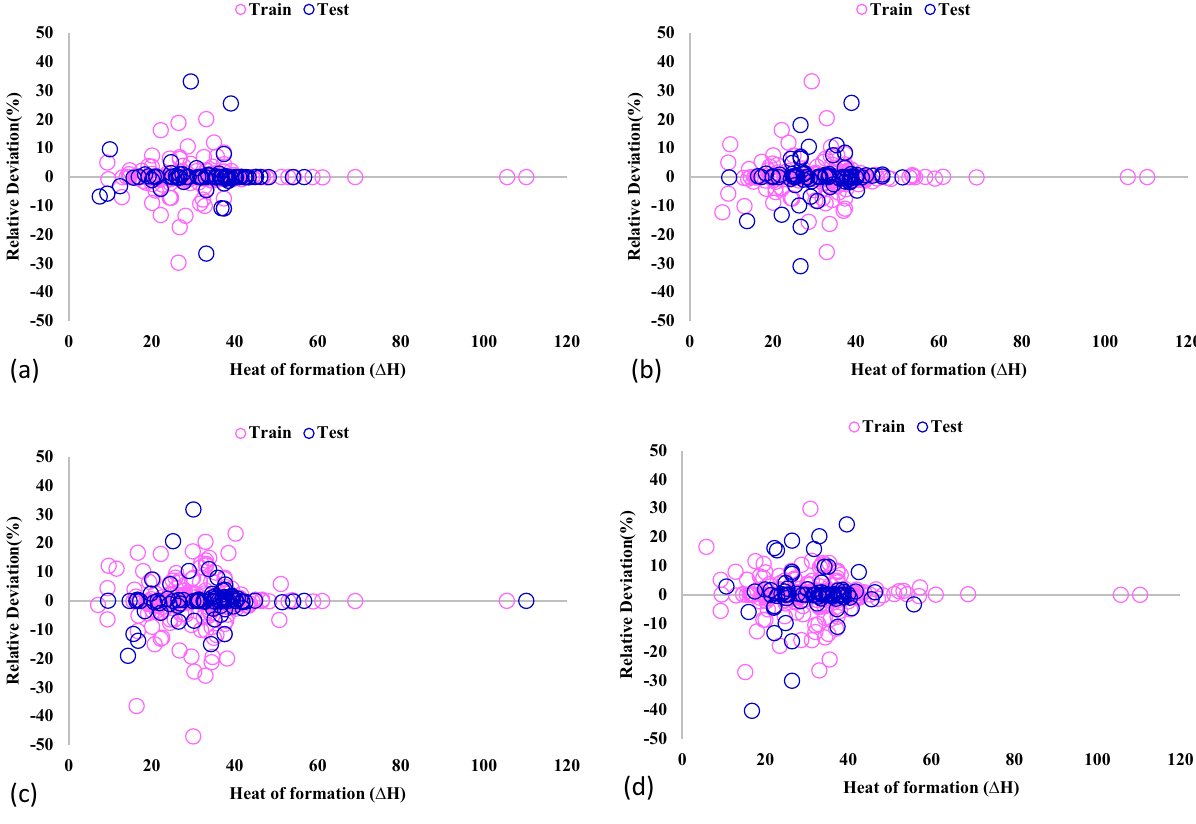
Figure 6. Comparison of actual and anticipated data for GPR model containing kernel function of ( a ) Exponential, ( b ) Matern, ( c ) Squared exponential, ( d ) Rational